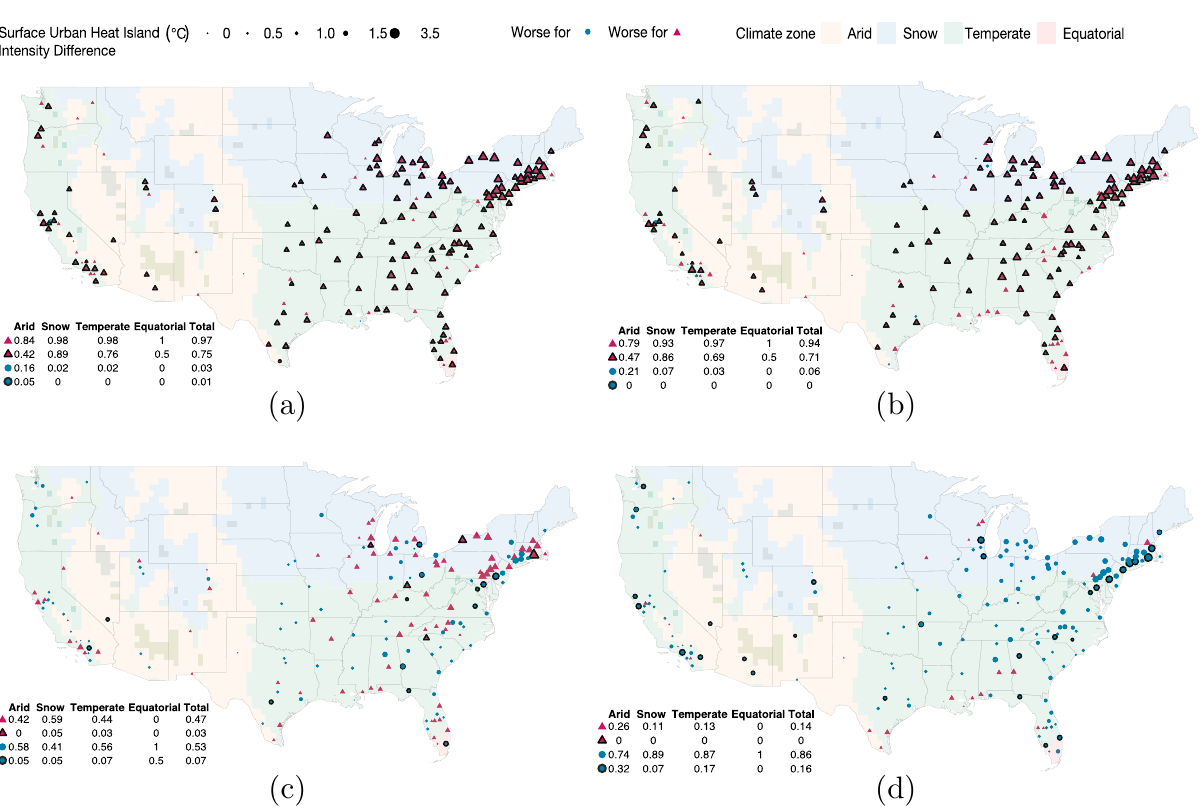
Fig. 2 Sociodemographic differences in mean summer daytime surface urban heat island intensity by major urban area. Symbols outlined in black depict statistically signi fi cant differences in mean exposures ( p < 0.05). Tables embedded in the lower left-hand corners indicate proportion of cities in each category (e.g., worse for ▵ or worse for ◦ ) by climate zone. Supplementary Table 1 provides detailed results for each city. Hispanic is de fi ned as all who report “ Hispanic, Latino, or Spanish origin ” as their ethnicity, regardless of race. People of color includes all Hispanic and all who do not identify as white alone. a Non-Hispanic white ( ◦ ) and people of color ( ▵ ). b Above 2 × poverty ( ◦ ) and below poverty ( ▵ ). c Below poverty ( ◦ ) and people of color ( ▵ ). d Below 65 ( ◦ ) and above 65 ( ▵